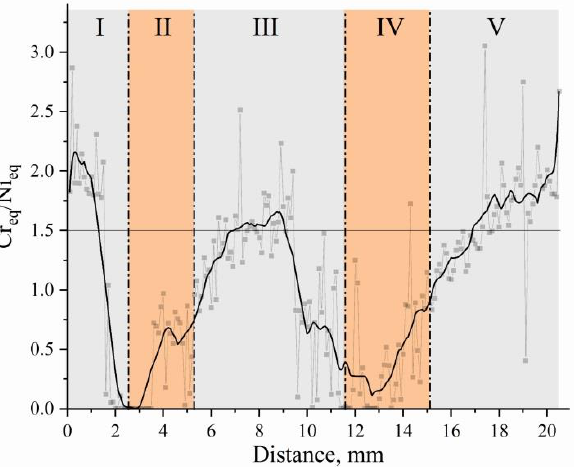
Figure 11. Change in the equivalent Cr eq and Ni eq ratio to the distance from the substrate in bimetal laminate macrocomposite produced by electron beam additive manufacturing.